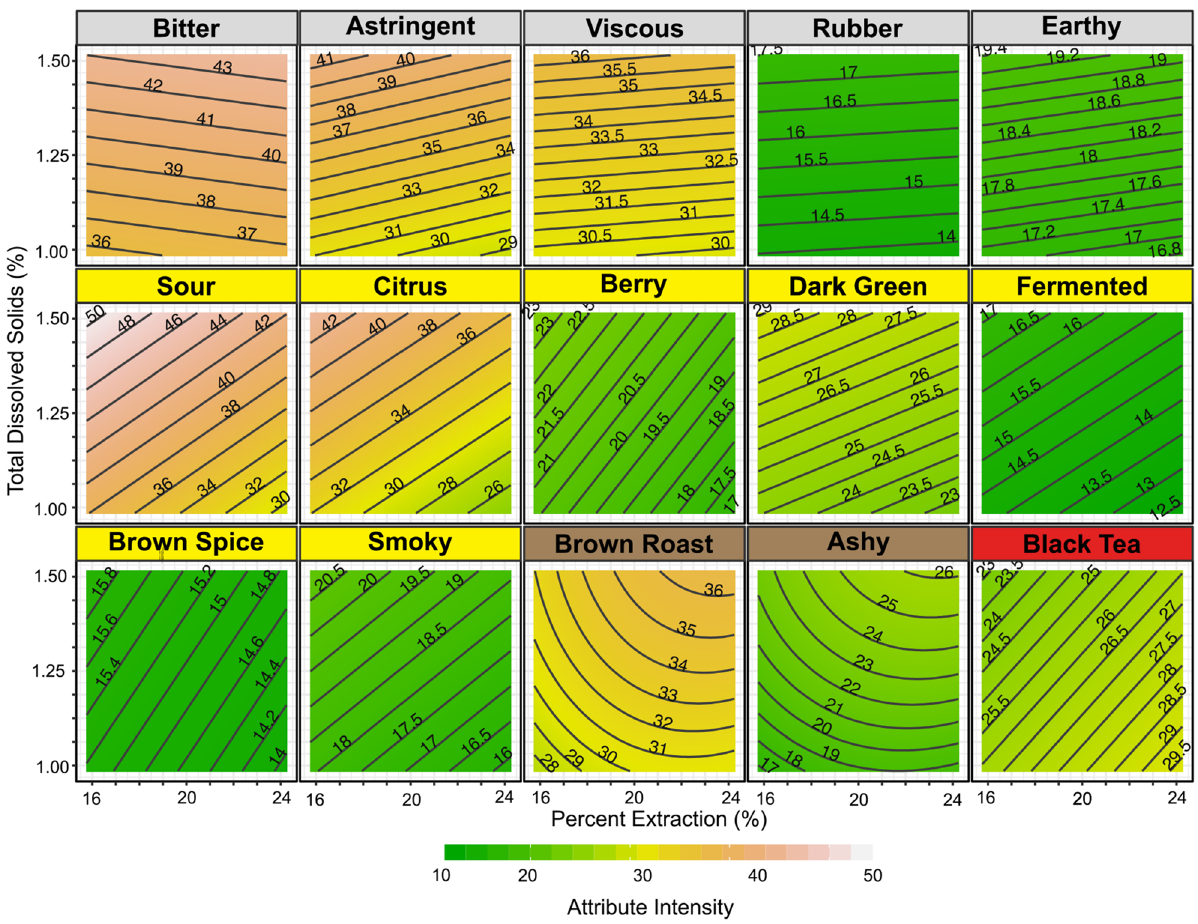
Figure 6. Contour plots of fitted response surface for attribute intensity versus total dissolved solids and percent extraction for all sensory attributes found to vary significantly by ANOVA. Grey attribute titles indicate positive correlation with TDS only; yellow titles indicate a positive correlation with TDS and negative correlation with PE; brown titles indicate a second order fit increasing with both TDS and PE; and red title indicates a negative correlation with TDS and positive correlation with